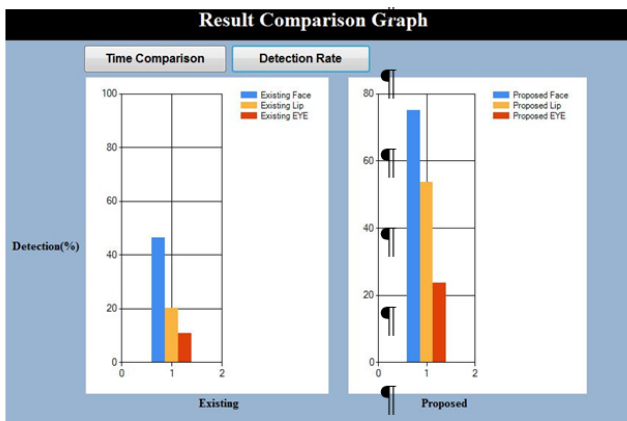
Fig. 2. Performance analysis of existing algorithms and proposed algorithm that compares the detection rate of